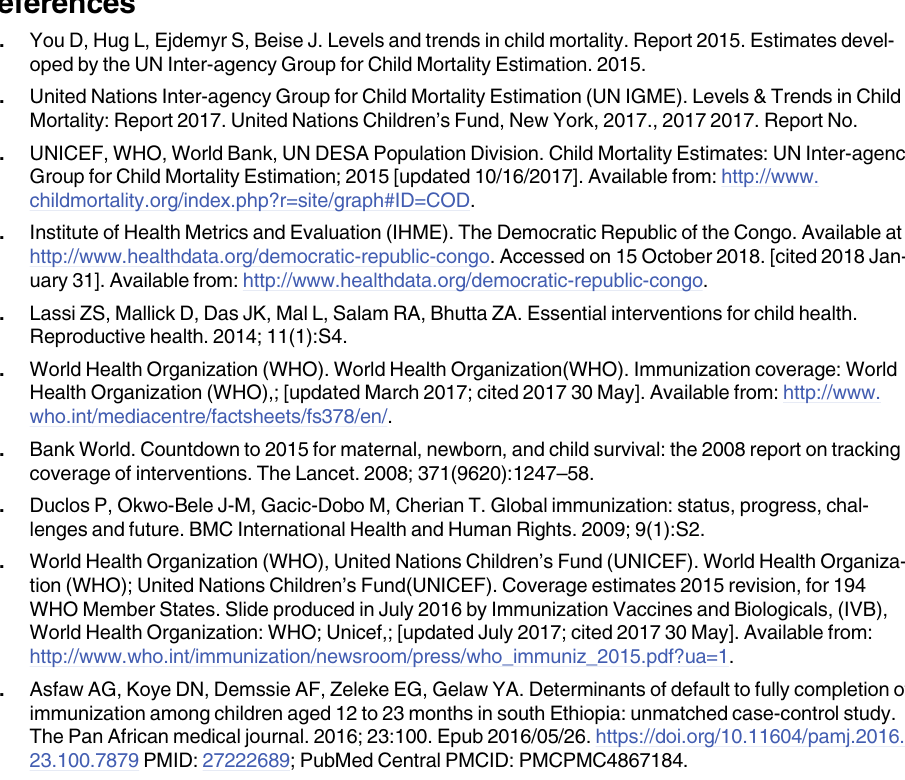
S1 Fig. Level of full immunization coverage in